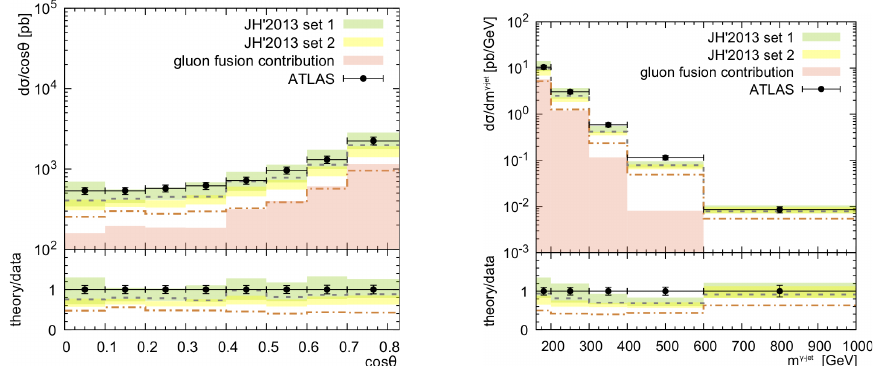
Figure 4. The di ff erential cross sections of associated prompt photon and jet production at √ s = 7 TeV as function of scattering angle cos θ and the invariant mass of the prompt photon and the leading jet. Additional cuts cos θ < 0 . 83, m γ − jet > 161 GeV and is the same as in Fig. 1. The experimental data are from ATLAS[20].